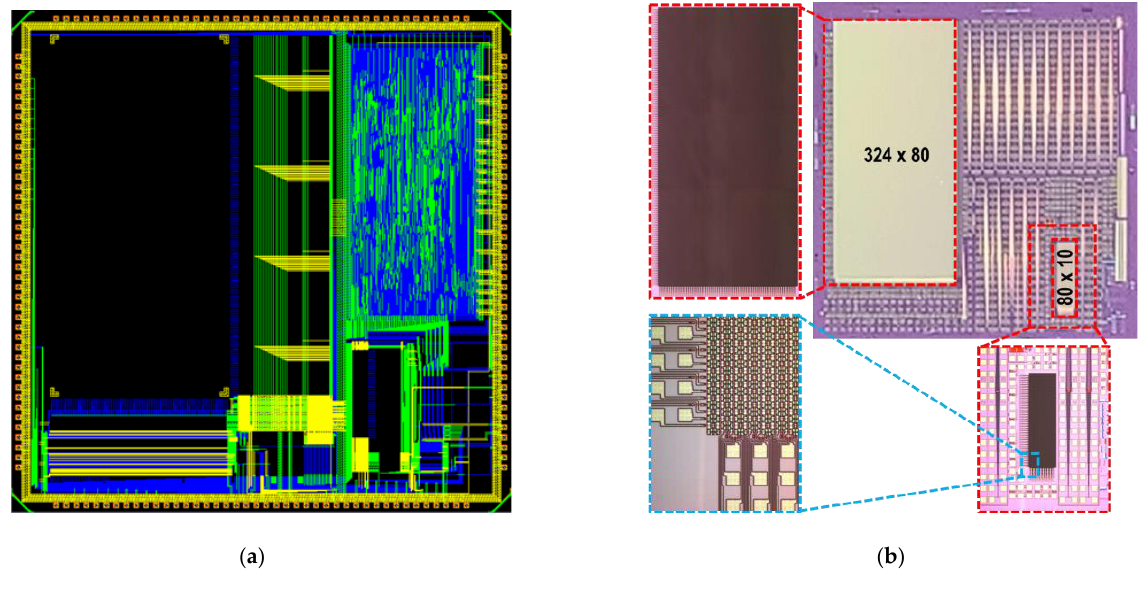
Figure 15. ( a ) Layout of the proposed accelerator chip designed using 0.35 µ m CMOS process, and ( b ) fabricated eFlash-based synapse arrays using conventional CMOS technology.